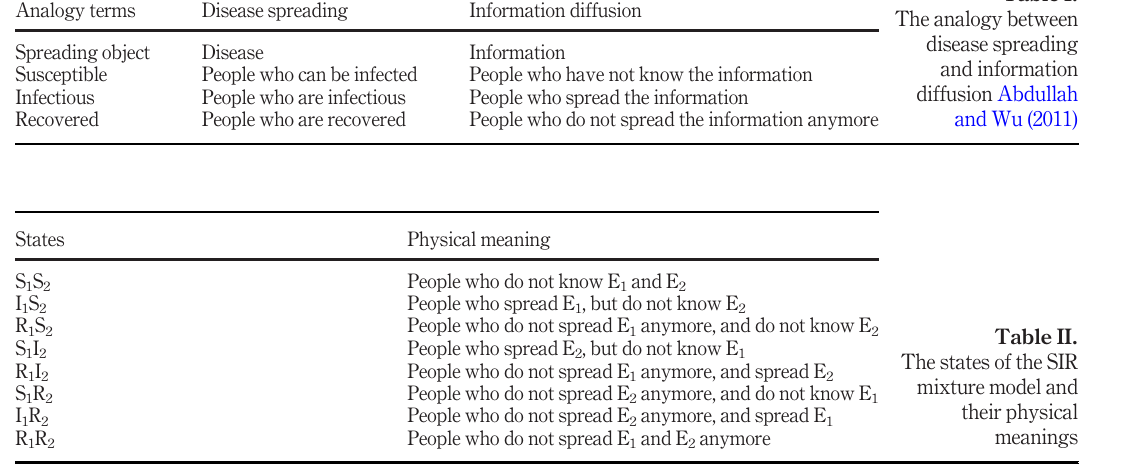
Table I. The analogy between